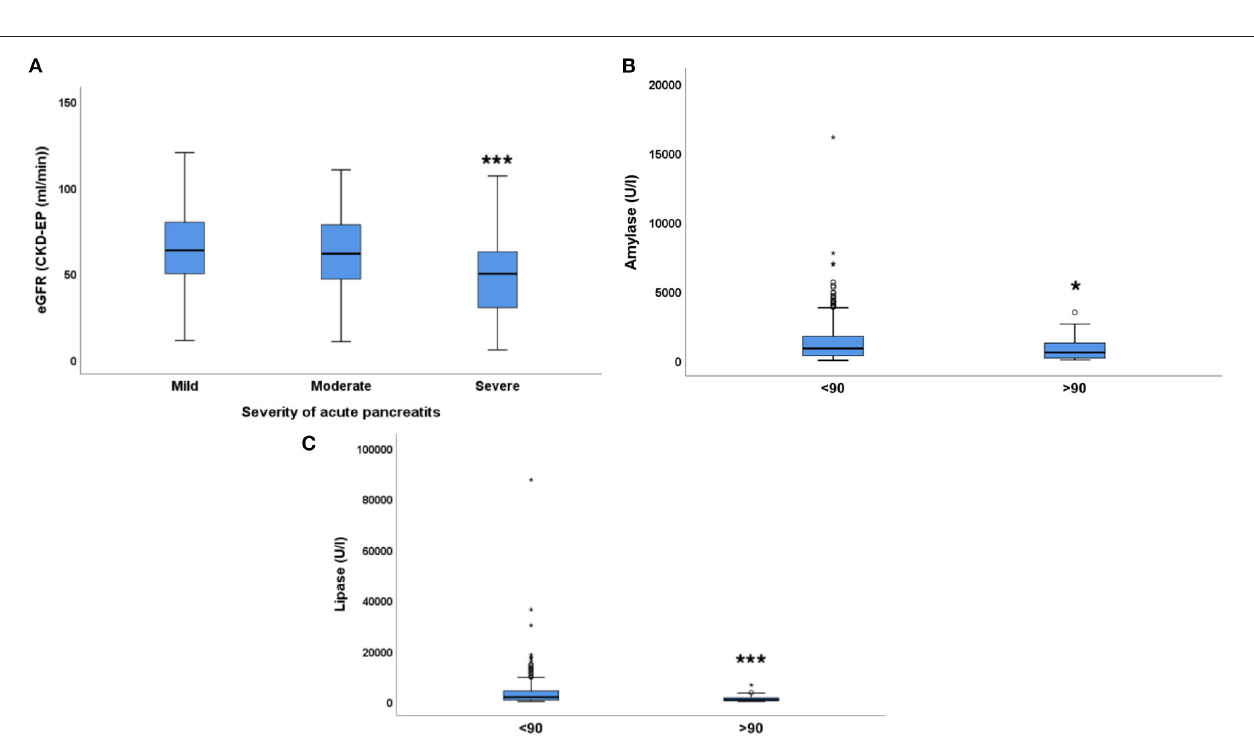
FIGURE 2 | The relationship between eGFR and acute pancreatitis severity. (A) severity of acute pancreatitis, (B) Amylase (U/L), (C) Lipase (U/L); median ± IQR, (A) one-way ANOVA with Bonferroni post-hoc test, *** p = 0.002 (severe vs. moderate); p < 0.001 (severe vs. mild). (B,C) unpaired t -test with Welch correction. * p < 0.01, *** p < 0.001. Small circles and stars represent outlier data.